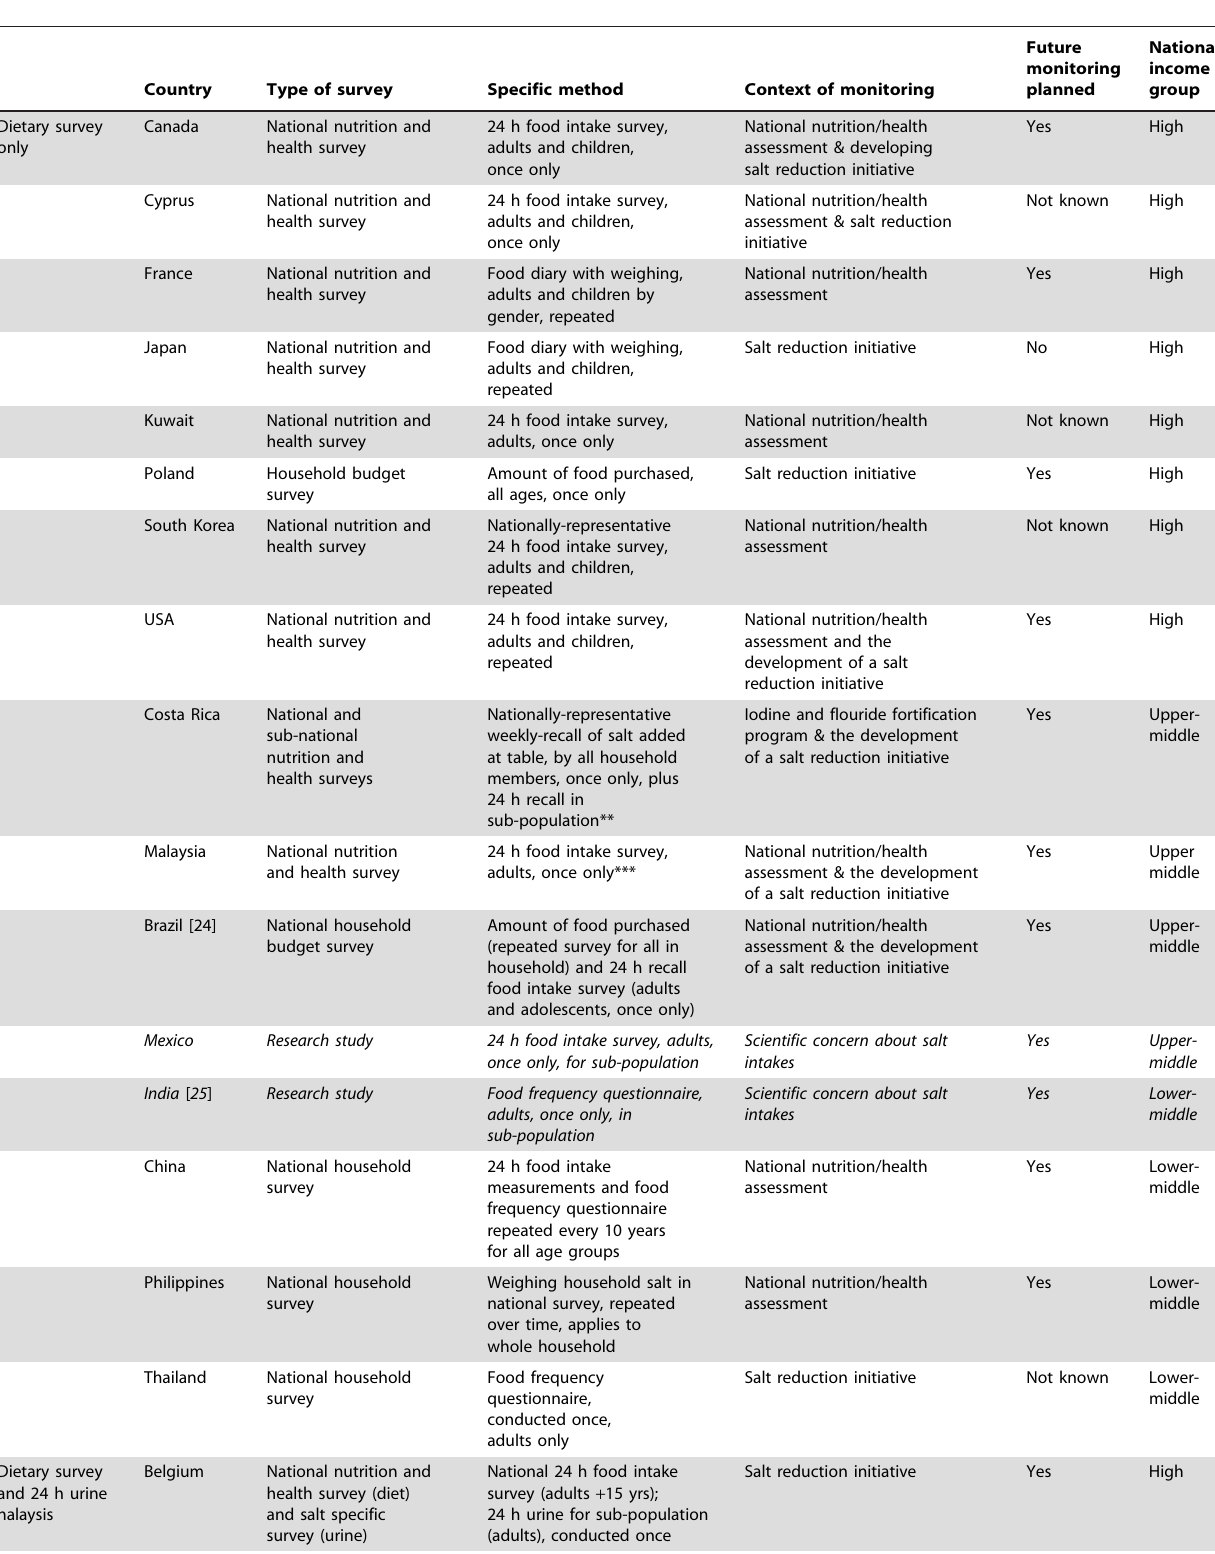
Table 1. Methods of monitoring of salt intake in countries participating in the survey, sorted by method and national income